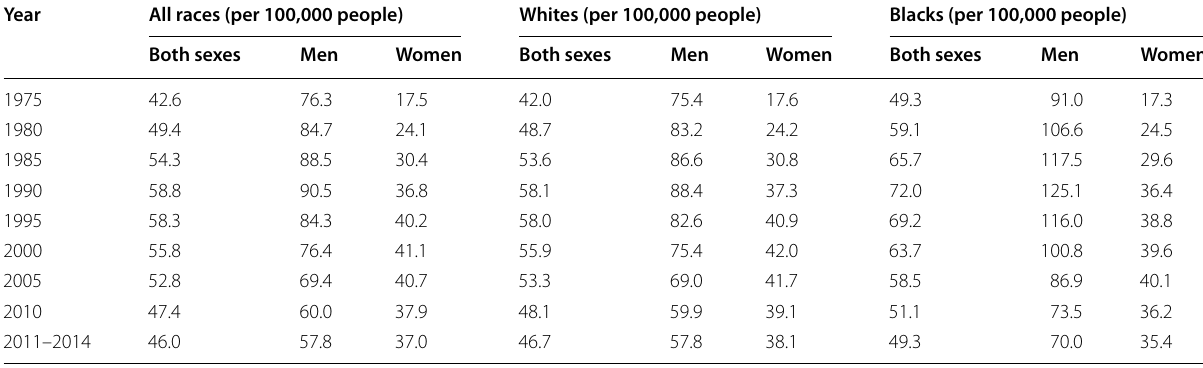
Table 3 Age-adjusted rate of lung cancer mortality in the United States (1975–2014) Year All races (per 100,000 people)